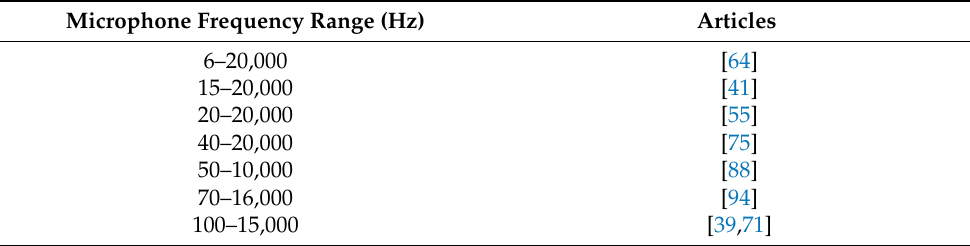
Table 5. Microphone